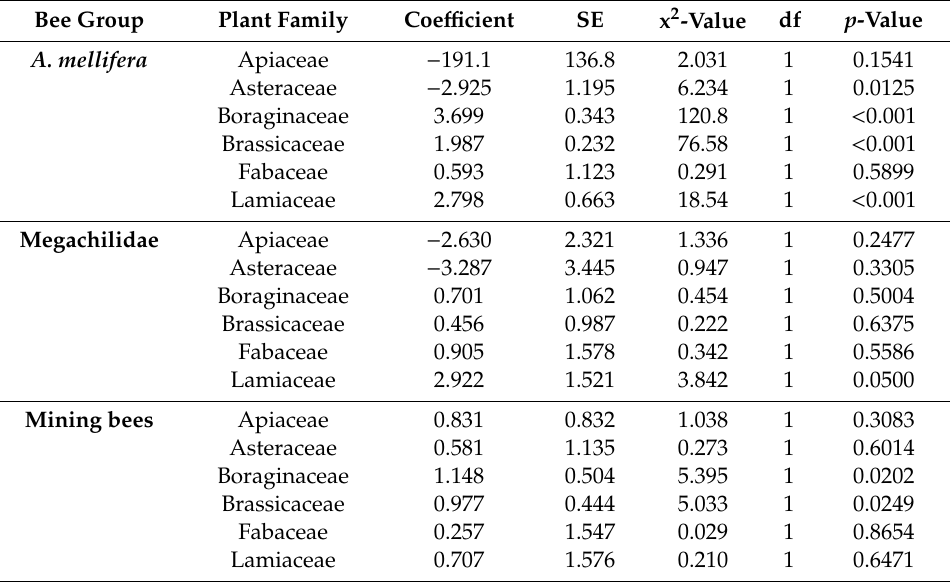
Table 3. Coe ffi cients and statistics of the GLMMs for the analysis of the abundance of di ff erent groups of bees in the visual sampling as a function of the floral resources of the di ff erent plant families in margins. SE, standard errors of the coe ffi cients; df, degrees of